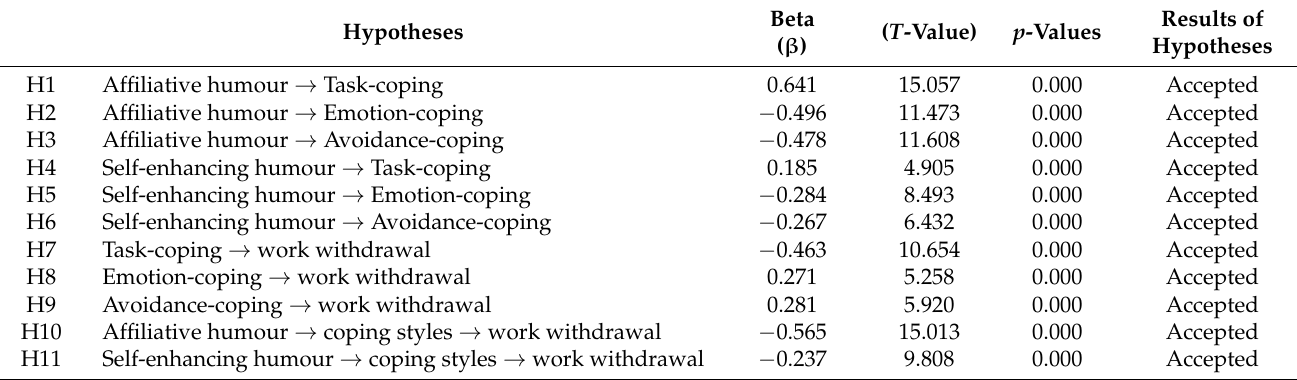
Table 6. The structural model’s results.